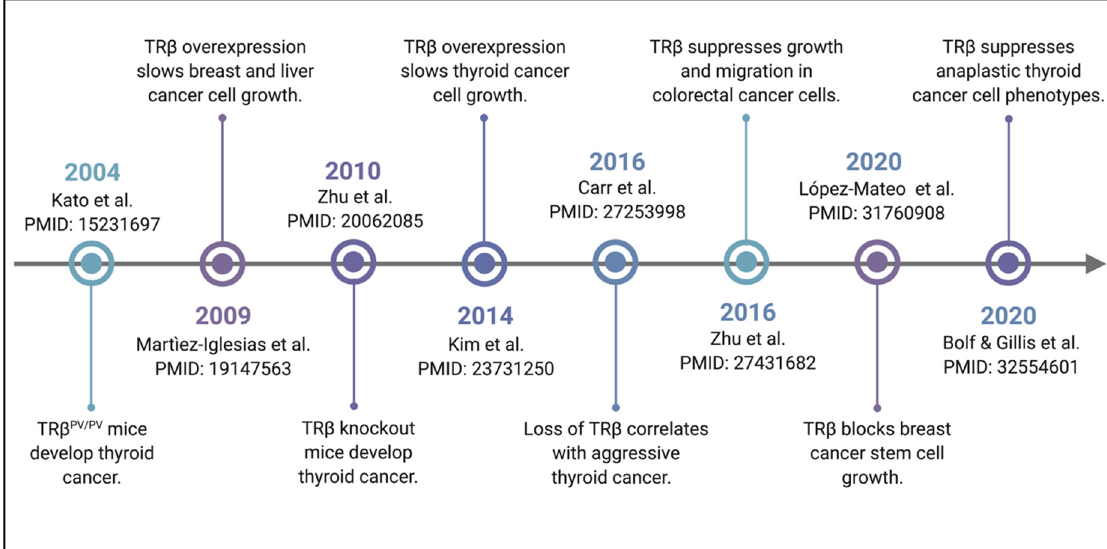
Figure 1. Timeline of seminal studies of TR β tumor suppression. TR β function was first linked to cancer growth when it was shown that an expression of ligand-binding domain mutant (TRB PV ) in mice led to spontaneous development of thyroid tumors. Increasing numbers of studies have demonstrated over the following two decades that TR β is a classically-defined tumor suppressor.